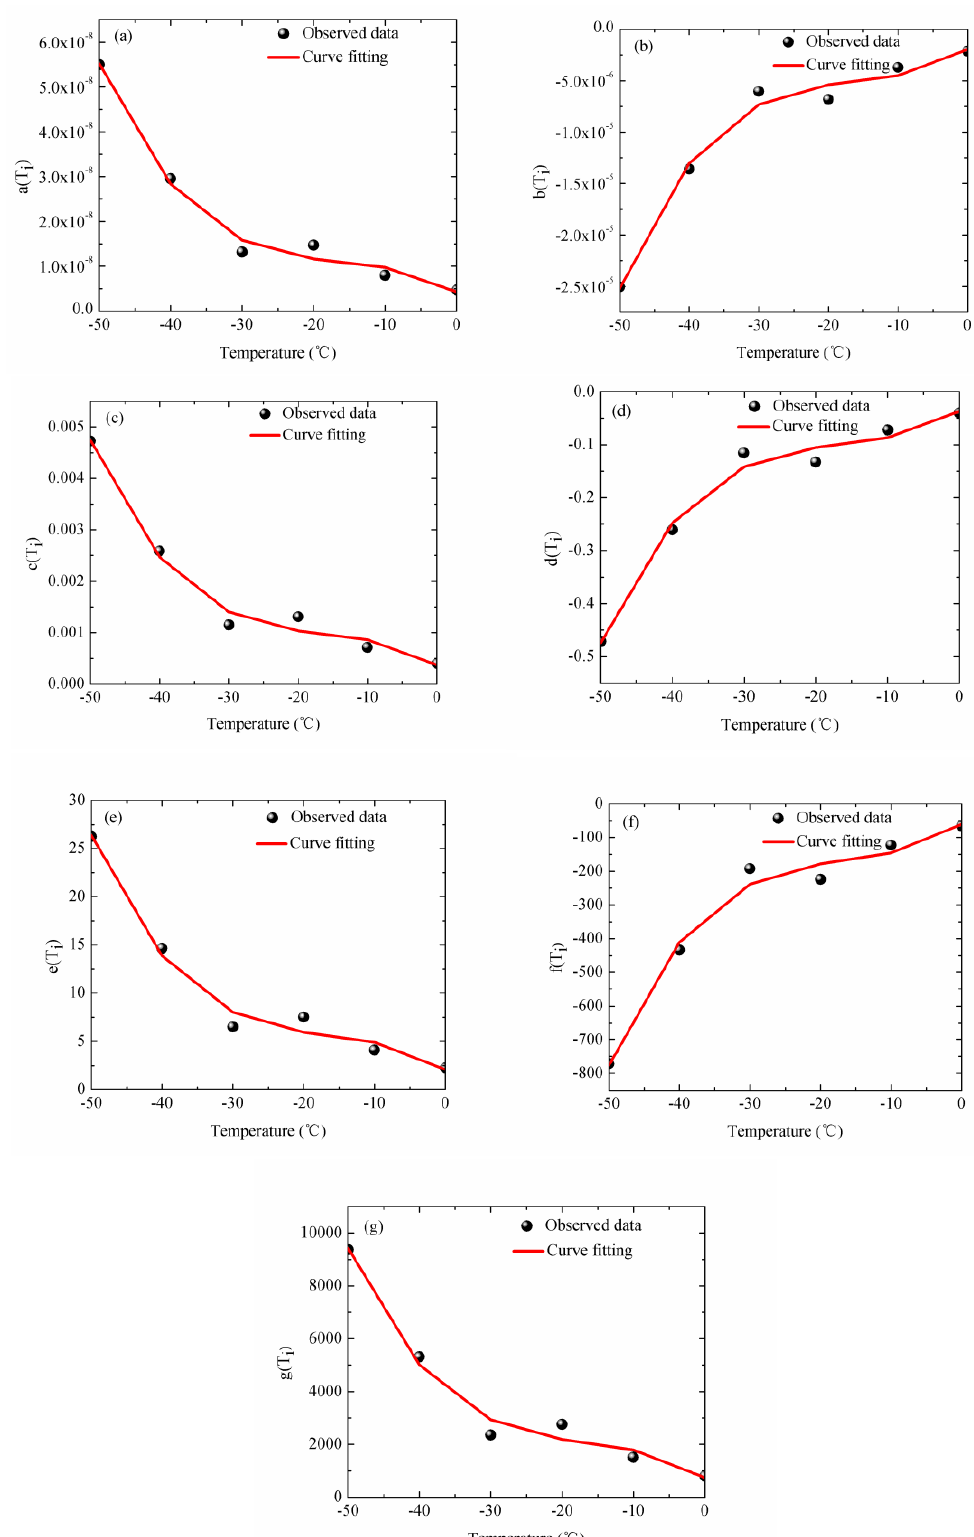
Figure 6. ( a )-( g ) show the coefficients a ( T i ), b ( T i ), c ( T i ), d ( T i ), e ( T i ), f ( T i ) and g ( T i ) from −50 °C to 0 °C,